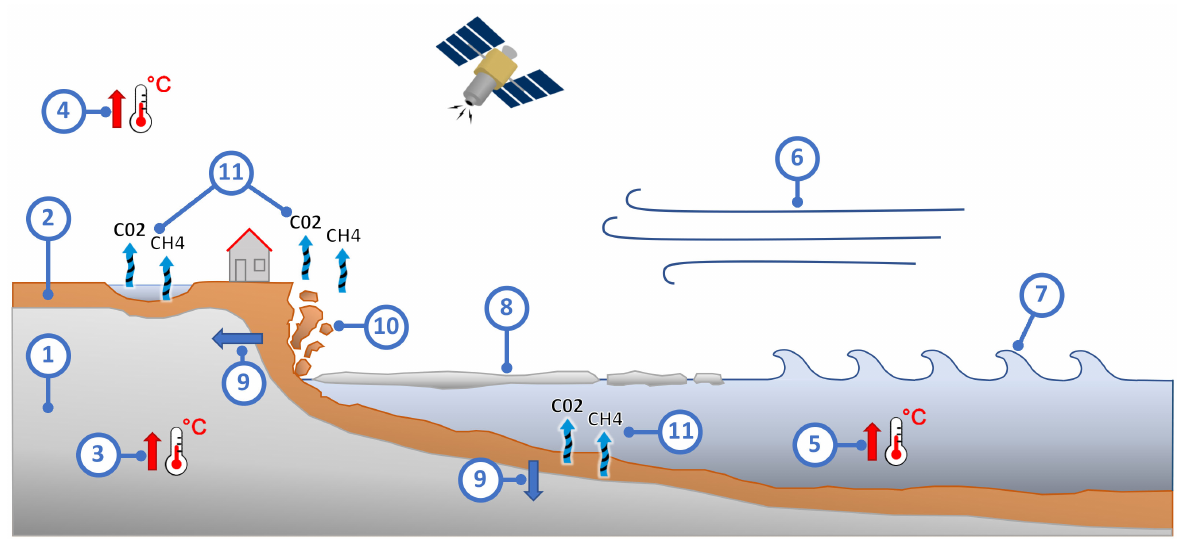
Figure 1. The info-graphic illustrates a variety of processes and features connected to increased erosion rates of Arctic permafrost coasts: ( 1 ) Permafrost, ( 2 ) unfrozen ground material, ( 3 ) in- creasing permafrost temperatures, ( 4 ) increasing air temperatures, ( 5 ), increasing sea temperatures, ( 6 ) increasing storminess, ( 7 ) wave action, ( 8 ) decreasing sea-ice extent, ( 9 ) decreasing permafrost extent, ( 10 ) coastal erosion, ( 11 ) release of organic carbon. Some symbols within the info-graphic were adopted or modified according to and courtesy of the Integration and Application Network, University of Maryland Center for Environmental Science